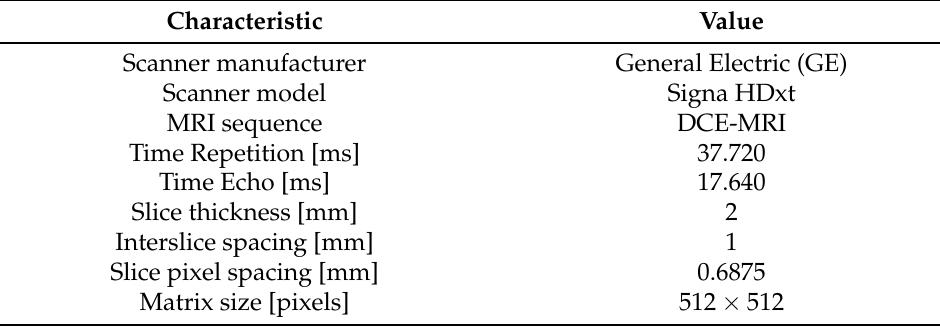
Table 1. Some characteristics of the DCE-MRI dataset used for this